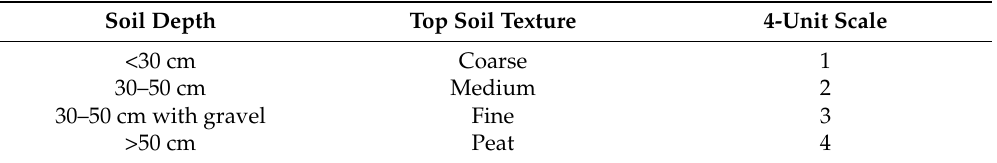
Table 2. The 4-unit scale of the two soil